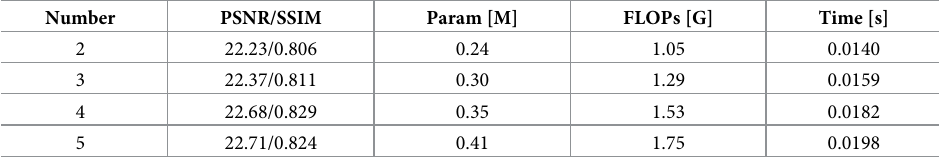
Table 7. Study on the number of Multi-scale Feature Aggregation Blocks (MFABs).